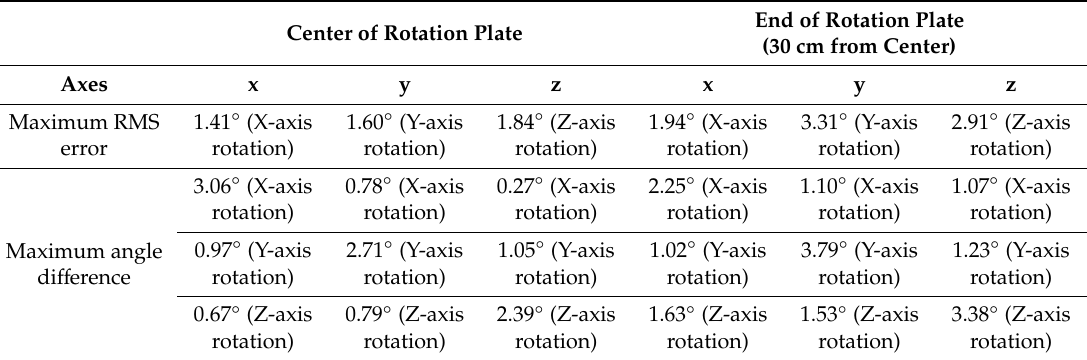
Figure 5. Performance evaluation of the wireless epidermal six-axis IMU. ( a ) Euler angle estimation at the center of the rotation plate; ( b ) Euler angle estimation at the end of the rotation plate. Table 1. Summarized performance evaluation